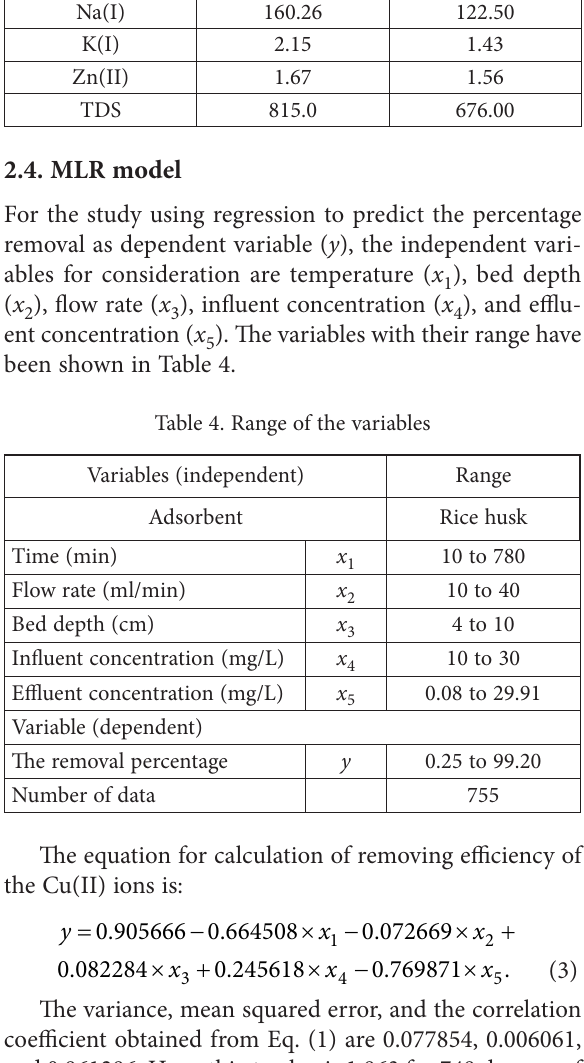
and 0.961296. Here, this t -value is 1.963 for 749 degrees of freedom, and the confidence range has been 95%. Figure 9 shows the correlation